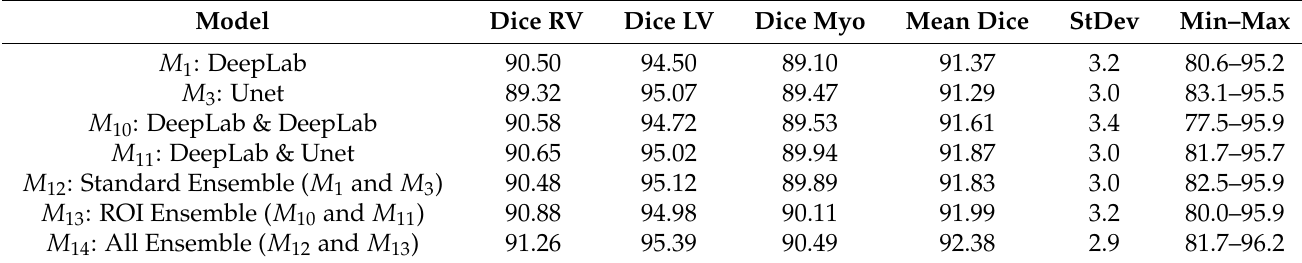
Table 4. Results on the ACDC validation set (RV—right ventricle, LV—left ventricle, Myo—myocardium). Model Dice RV Dice LV Dice Myo Mean Dice StDev Min–Max